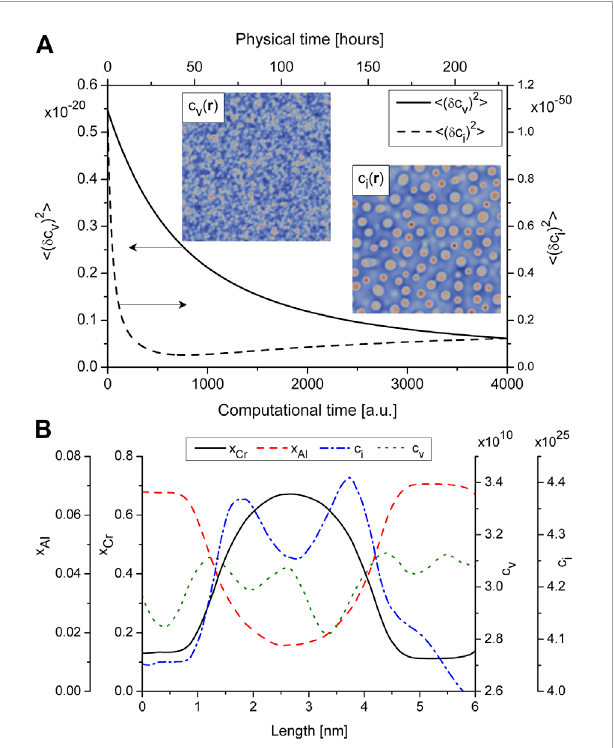
FIGURE 4 (A) (color online) Dynamics of the order parameters ⟨( δ c i ) 2 ⟩ and ⟨( δ c v ) 2 ⟩ at annealing of the solid solution Fe − 30 %Cr − 5 %Al at T = 710 K . In the snapshots of point defects distribution (obtained at t = 230 h) c i varies from 3 . 6 × 10 −25 (blue) to 5 . 9 × 10 −25 (red) and c v varies from 2 . 6 × 10 −10 (blue) to 4 . 4 × 10 −10 (red). (B) Profiles of concentration of alloying elements (solid line for Cr, dash line for Al) and point defects (dash-dot and dot lines for interstitials and vacancies, respectively) (obtained at t = 230